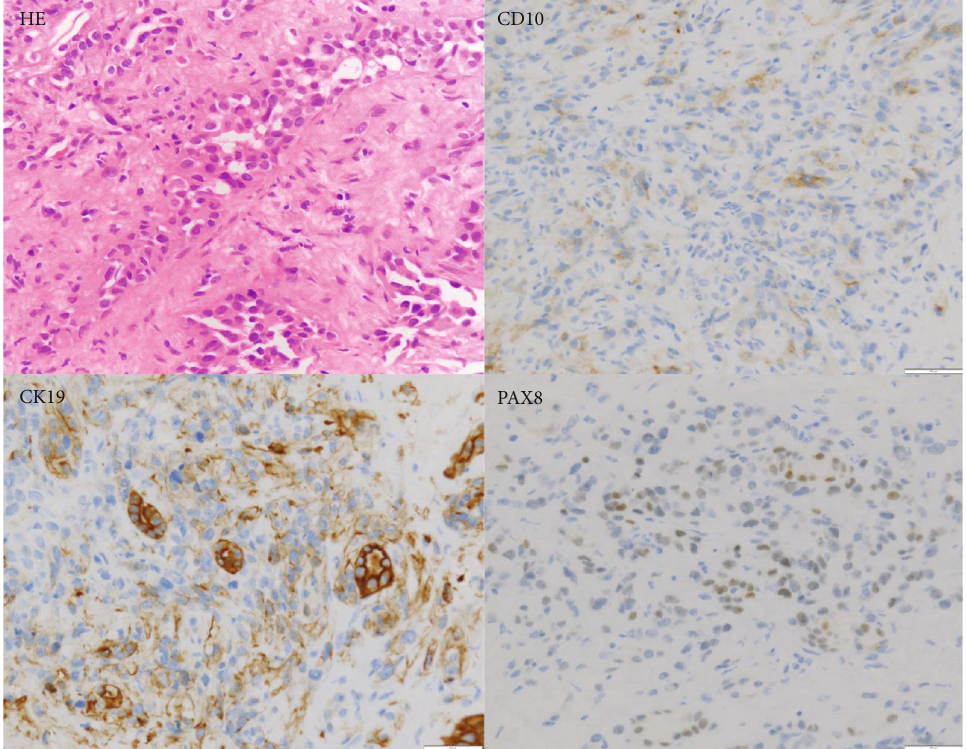
Figure 3: Hematoxylin and eosin staining and immunohistochemical staining of tissue from the renal biopsy in Case 2 ( × 400).